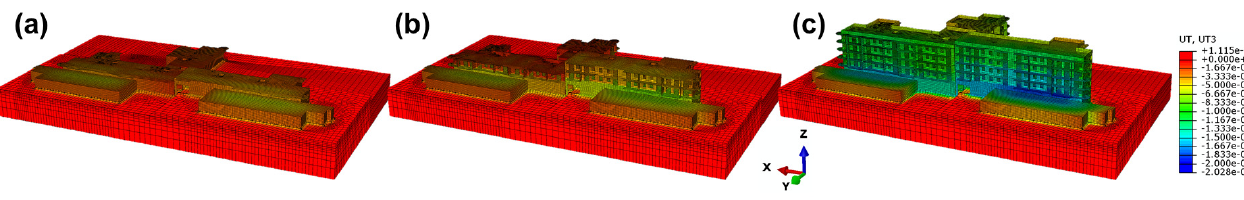
Figure 16. Maps of final vertical displacements [m]: ( a ) RIGID model, ( b ) AREA model. Table 7 lists the actual and calculated vertical displacements, as well as absolute and relative calculation errors. The average settlement and calculation error for the HOMO and AREA models were almost the same. However, there are local discrepancies in the results, which proves that the heterogeneity of the loess subsoil causes non-uniform set-